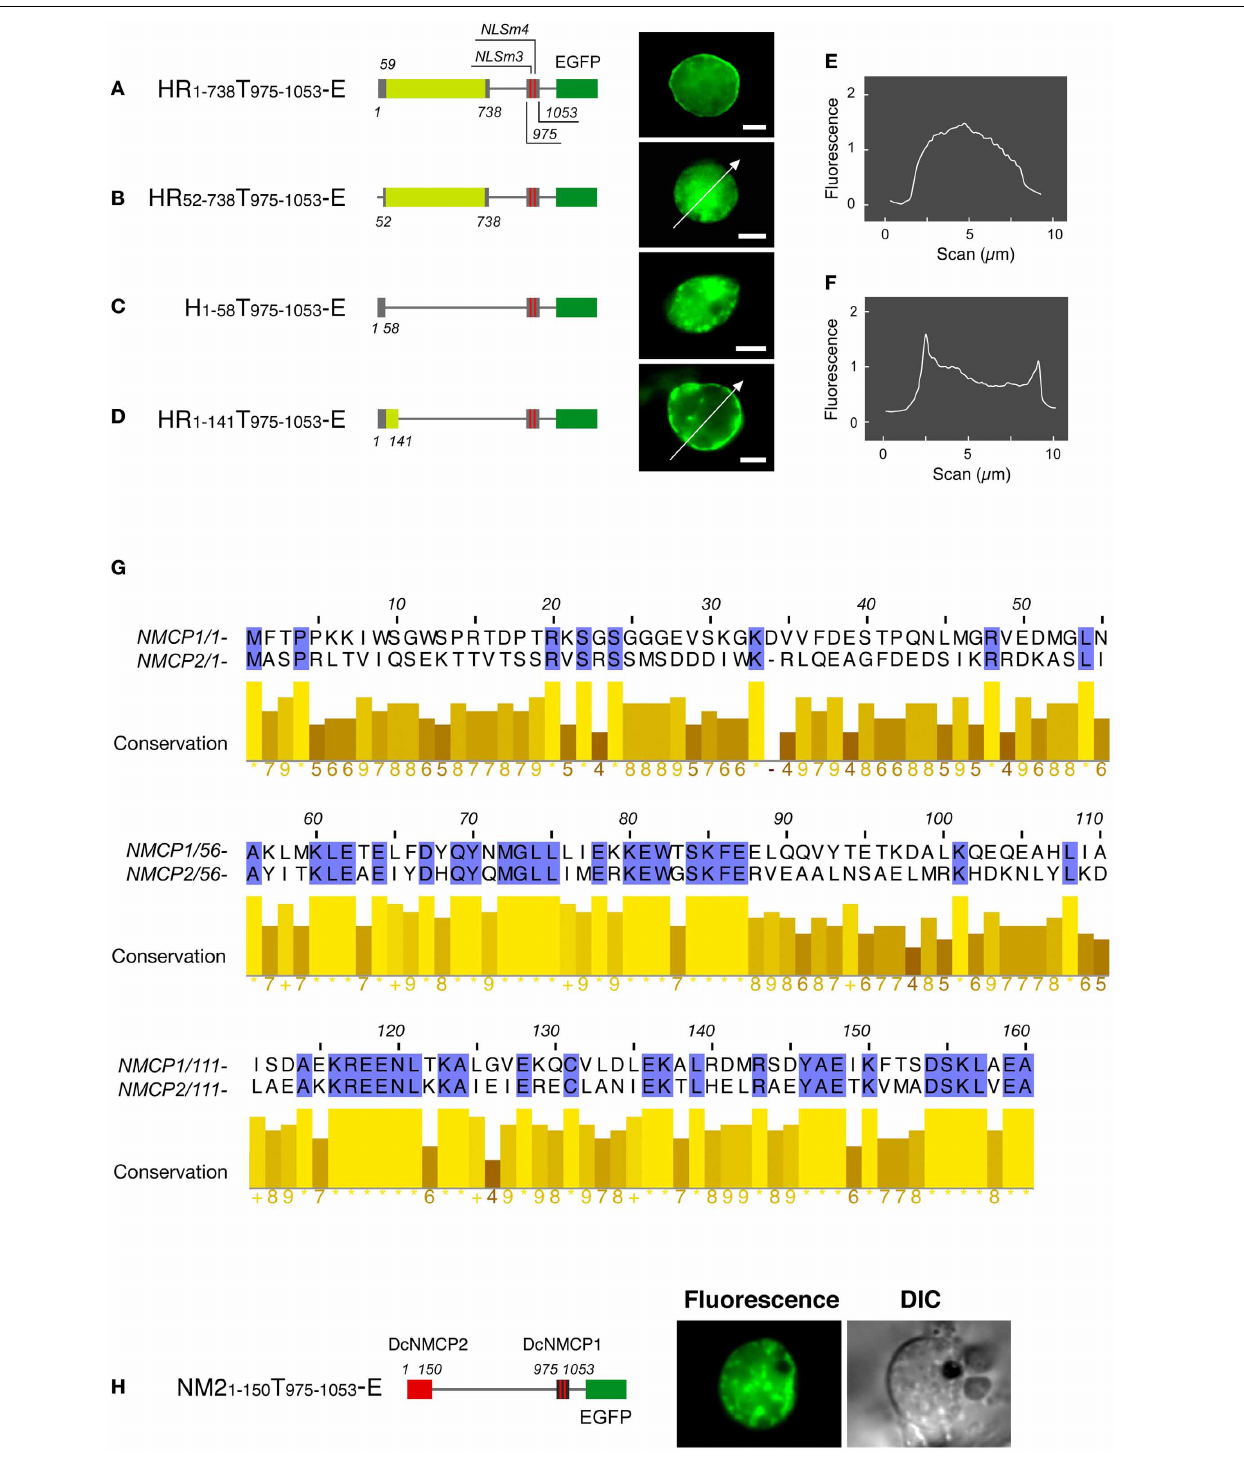
FIGURE 2 | The N-terminal region is required for the DcNMCP1 to localize to the nuclear periphery. Identification of the region required for localization to the nuclear periphery (A–D) . Constructs of fusions are schematically represented in the left of micrographs. The micrographs show EGFP-fluorescence of A. graveolens cells expressing fusion proteins, and the fluorescence intensity distribution along the lines indicated in (B) and (D) are